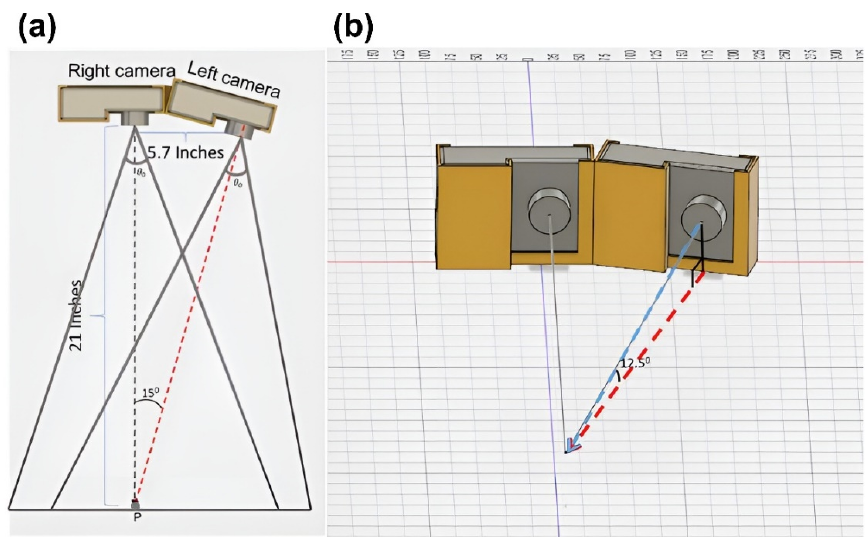
Figure 6. Spatter detection system for stereo vision: ( a ) the horizontal angle between the two sensors is 15°; ( b ) the vertical direction of the sensor is 12.5° from the observation object. (Reprinted with permission from Ref. [43]. Copyright 2018 University of Texas at Austin.). Table 2. In situ detection system for L-PBF.